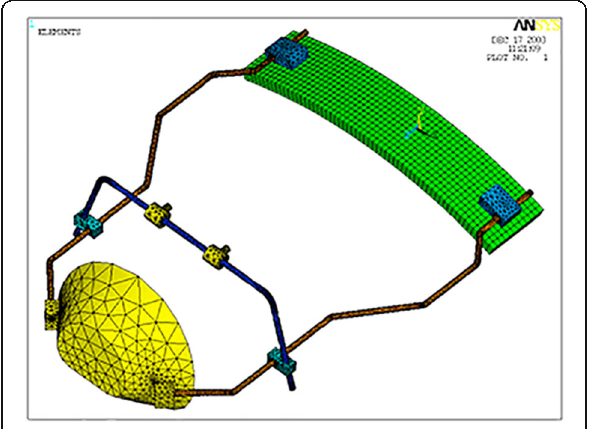
Fig. 2 3D model meshes. Twenty-eight thousand six hundred ninety- six nodes and 40,178 elements characterized the numerical